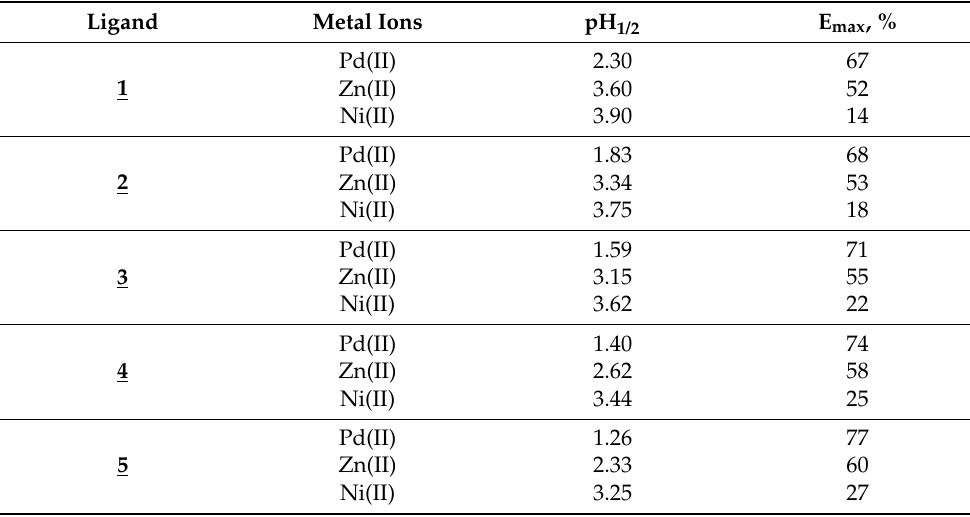
Table 3. The pH 1/2 values for extraction of Pd(II), Zn(II) and Ni(II) complexes with 1-alkyl-1,2,4-triazole. Ligand Metal